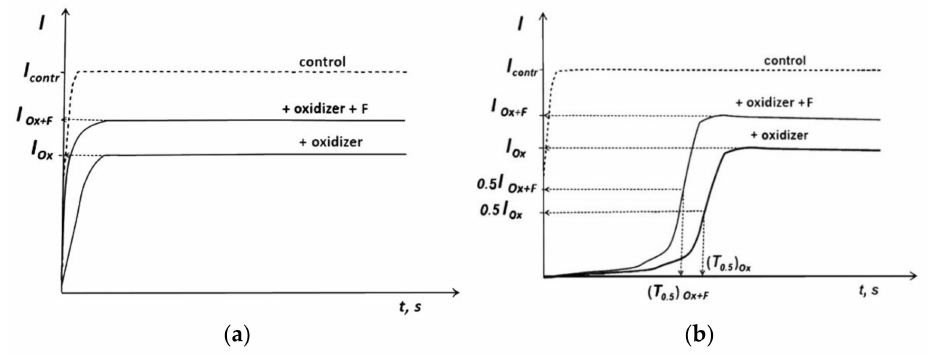
Figure 6. Bioluminescence kinetics in a solution of model oxidizer (Ox) and fullerenol (F): ( a ) cellular assay; ( b ) enzymatic